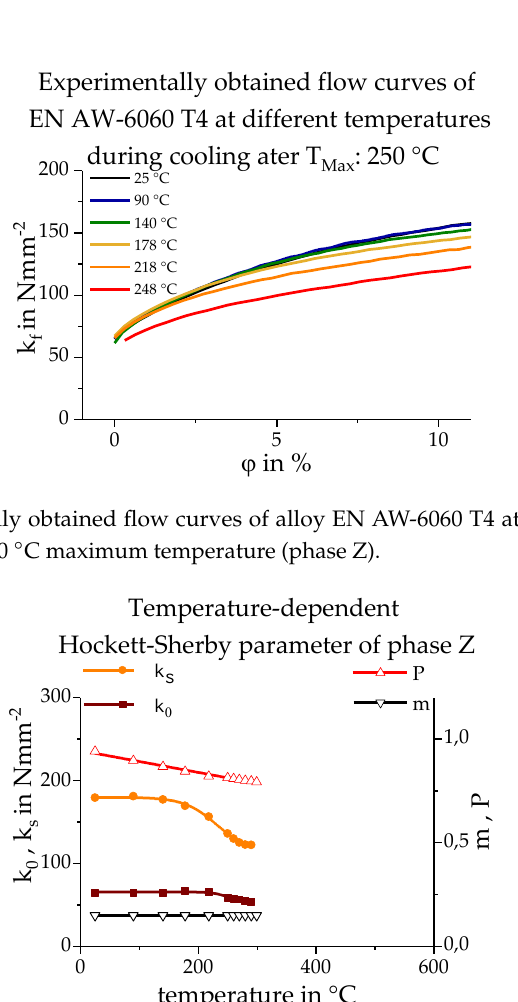
Figure 14. Temperature-dependent Hockett–Sherby parameters of phase (Z).